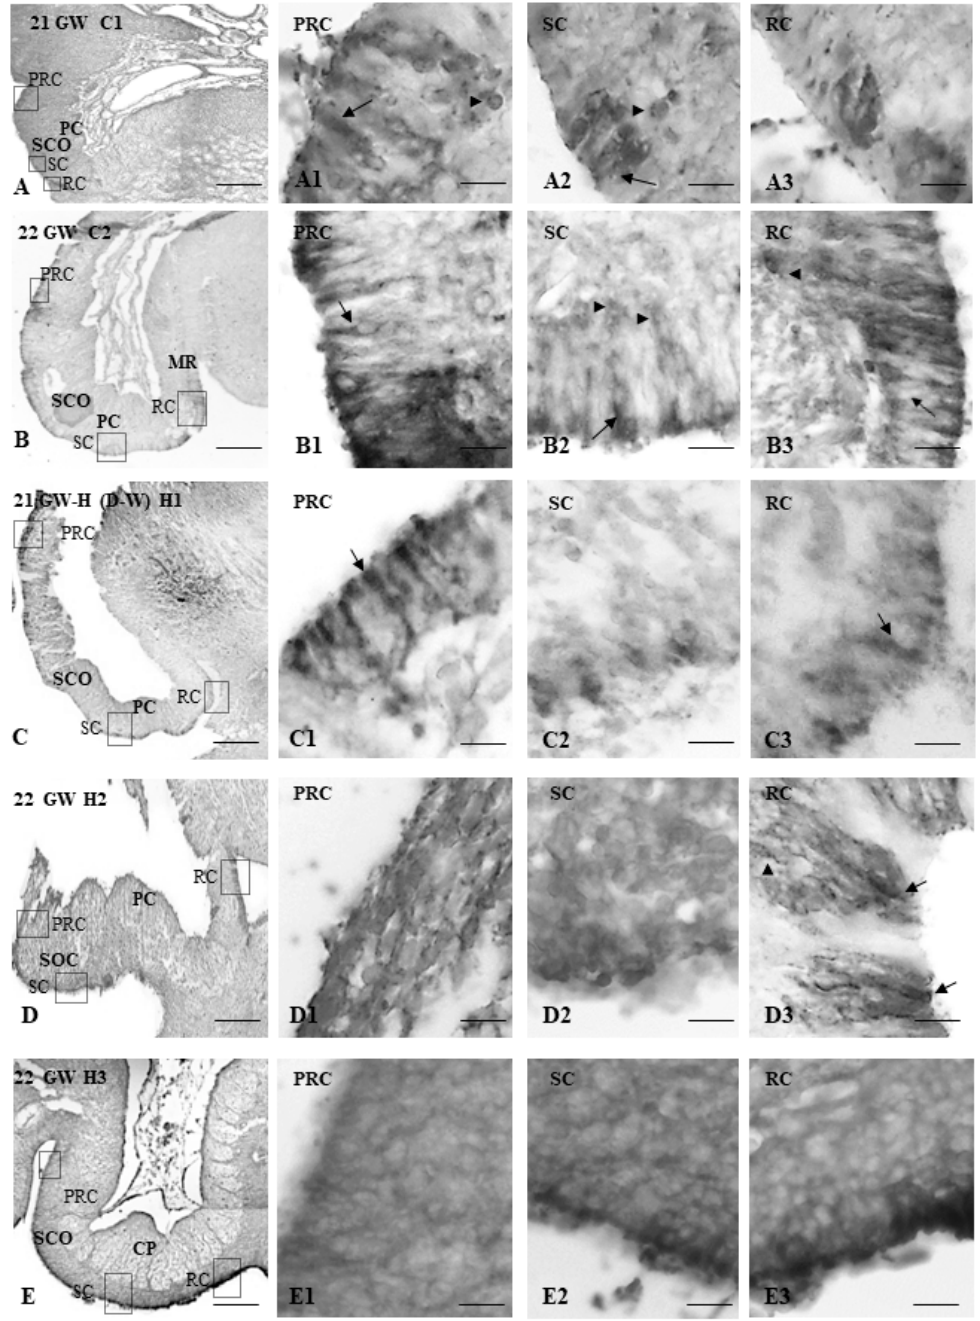
Figure 2. ( A ) Panoramic view of the SCO of a 21GW non-hydrocephalic control fetus ( C1 ), labeled with anti-transthyretin (TTR-ir) (bar = 250 µ m). ( A1 ): precommissural part of the SCO (bar = 25 µ m), ( A2 ): subcommissural part of the SCO (bar = 25 µ m), ( A3 ): retrocommissural part of the SCO (bar = 25 µ m). ( B ) Panoramic view of the SCO of a 22GW non-hydrocephalic control fetus ( C2 ), labeled with anti-transthyretin (TTR-ir) (bar = 250 µ m), ( B1 ): precommissural part of the SCO (bar = 25 µ m), ( B2 ): subcommissural part of the SCO (bar = 25 µ m), ( B3 ): retrocommissural part (bar = 25 µ m). In both cases controls TTR-ir is observed in group of ependymal cells and several hypendymal cells in the three parts of SCO. ( C ) Panoramic view of the SCO of a 21GW (H1) fetus with non-communicating hydrocephalus (Dandy–Walker), labeled with anti-transthyretin (TTR-ir) (bar = 250 µ m), ( C1 ): precommissural part of the SCO (bar = 25 µ m), ( C2 ): subcommissural part of